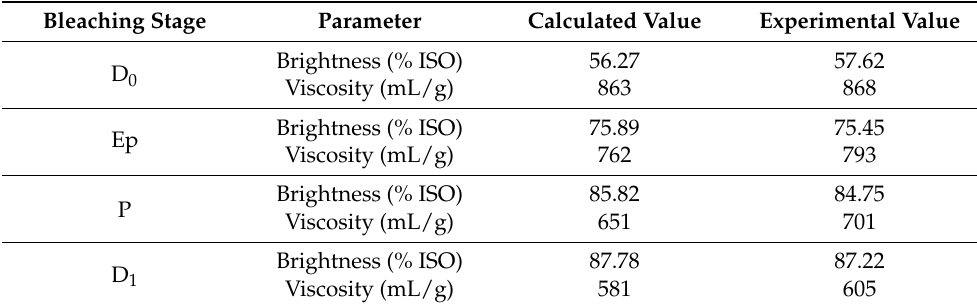
Table 6. Experimental and calculated values based on results of optimization. Bleaching